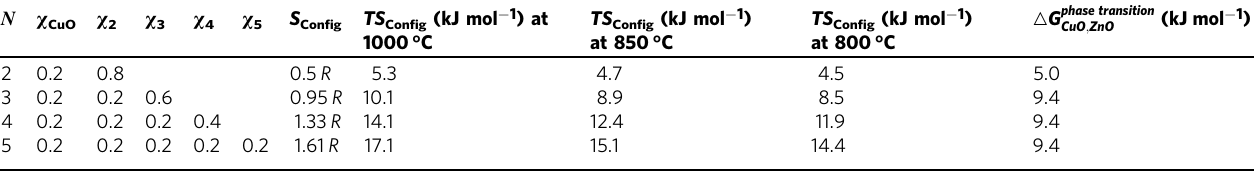
Table 1 Thermodynamic properties of the solid solutions reported in this